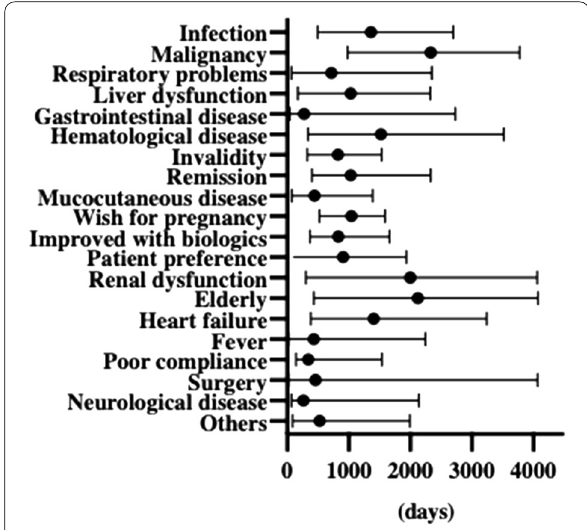
Fig. 1 Time to methotrexate (MTX) discontinuation according to the reason for MTX discontinuation. Duration of treatment until MTX discontinuation in patients with RA according to the reason for MTX discontinuation. Results are shown in days (median with interquartile range) according to the reasons; the time to MTX discontinuation was found to vary in accordance with the reasons ( P